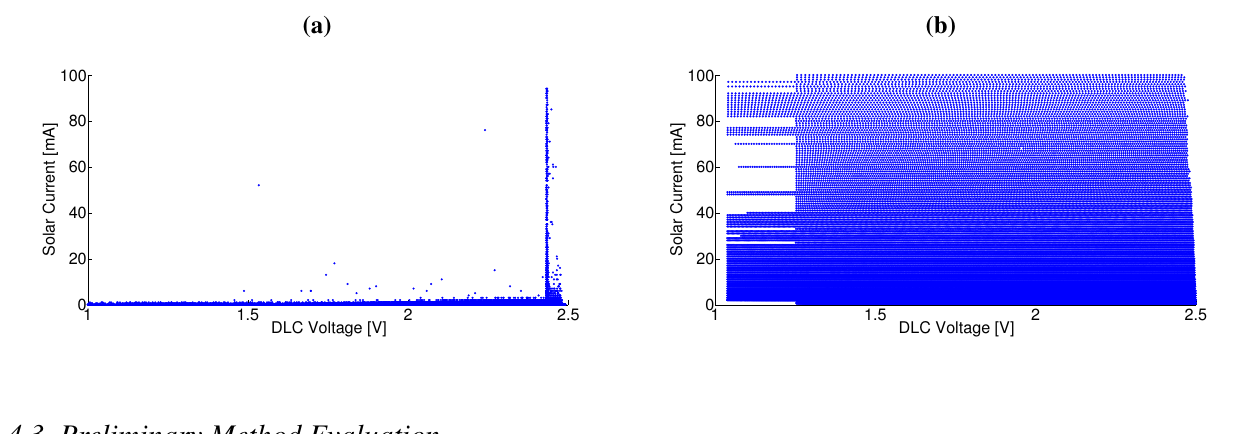
Figure 4. Comparison of ( a ) an empirical training dataset that is extracted from deployment data and ( b ) a synthetically generated training